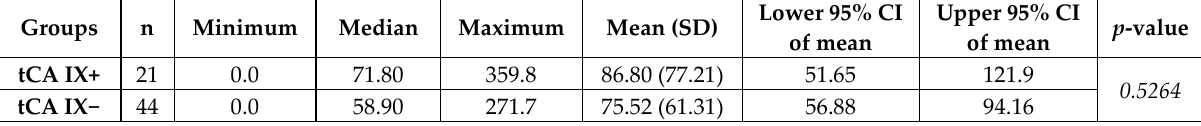
Figure A10. Analysis of sCA IX levels in plasma patients with CA IX-positive versus CA IX-negative tissue using R&D ELISA. Violin graphs with dots (plot all data) showing the distribution of sCA IX levels in tCA IX+ and tCA IX- groups determined by IHC. Cut off value, 37.8 pg/mL, is shown as red horizontal line. The table shows summary statistical data of sCA IX (pg/mL) for each group: number of patients (n), minimum, median, maximum, mean with standard deviation (SD), lower 95% confidence interval (CI) for mean, upper 95% CI for median, and the result of the unpaired t -test ( p = 0.5264 ).